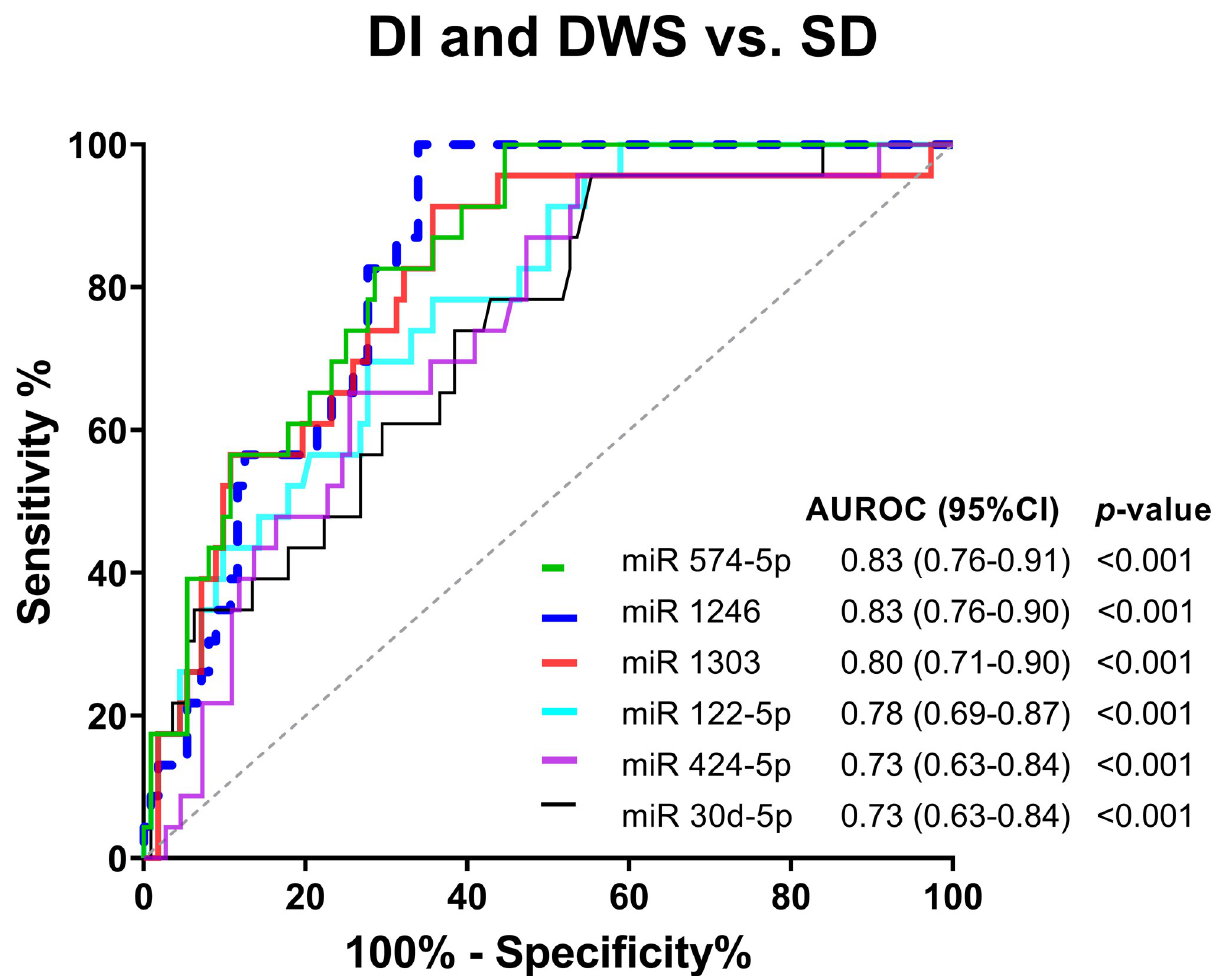
Fig 3. Receiver operating characteristic analysis of serum miRNAs for predicting severe dengue.